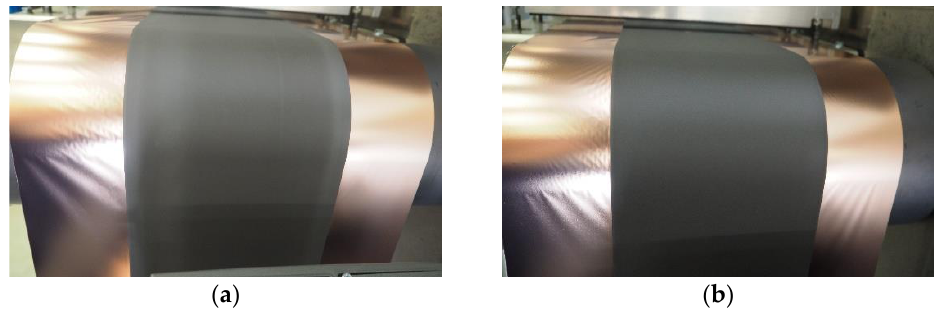
Figure 3. Silicon – graphite anodes ( a ) dried by convection, ( b ) dried by laser. Figure 3. Silicon–graphite anodes ( a ) dried by convection, ( b ) dried by laser.